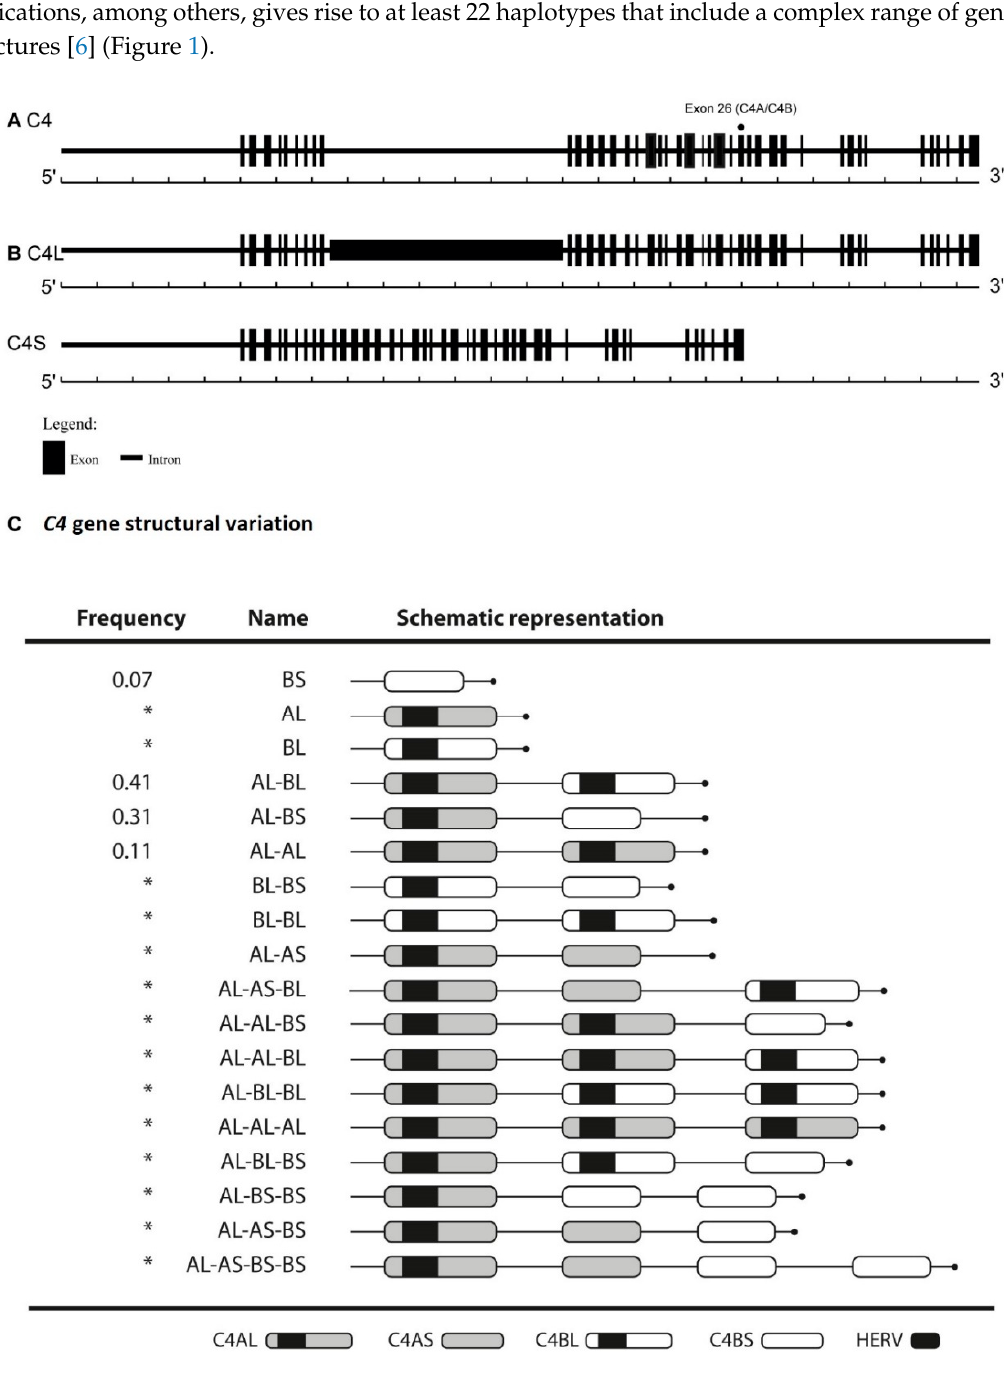
Figure 1. C4 gene structural variation. ( A ) C4A and C4B isoforms di ff er in four amino acids at positions 1101–1106 due to five nucleotide polymorphisms (exon 26). ( B ) The presence or absence of human endogenous retrovirus—6.34kb (HERV) in intron 9, results in C4L or C4S long C4 or short C4 gene, respectively. ( C ) C4 gene structural variation. AS haplotype carrying only the C4A short isoform; BS haplotype carrying only the C4B short isoform; AL haplotype carrying only the C4A long isoform; BL haplotype carrying only the C4B long isoform. In the figure, all di ff erent haplotypes are presented. Marked with an asterisk (*) are the least common in a European-ancestry population. The total number of C4 copies varies from two to eight in a diploid genome, corresponding to the sum of C4A and C4B genes [7]. C4 diverges also in terms of gene size, 76% of C4 genes harbor a retrovirus insert, HERV-K, integrated in the ninth intron, giving rise to the long C4 gene ( C4L ). The remaining 24% of the C4 genes do not have this retrovirus and are known as short C4 genes ( C4S ). A